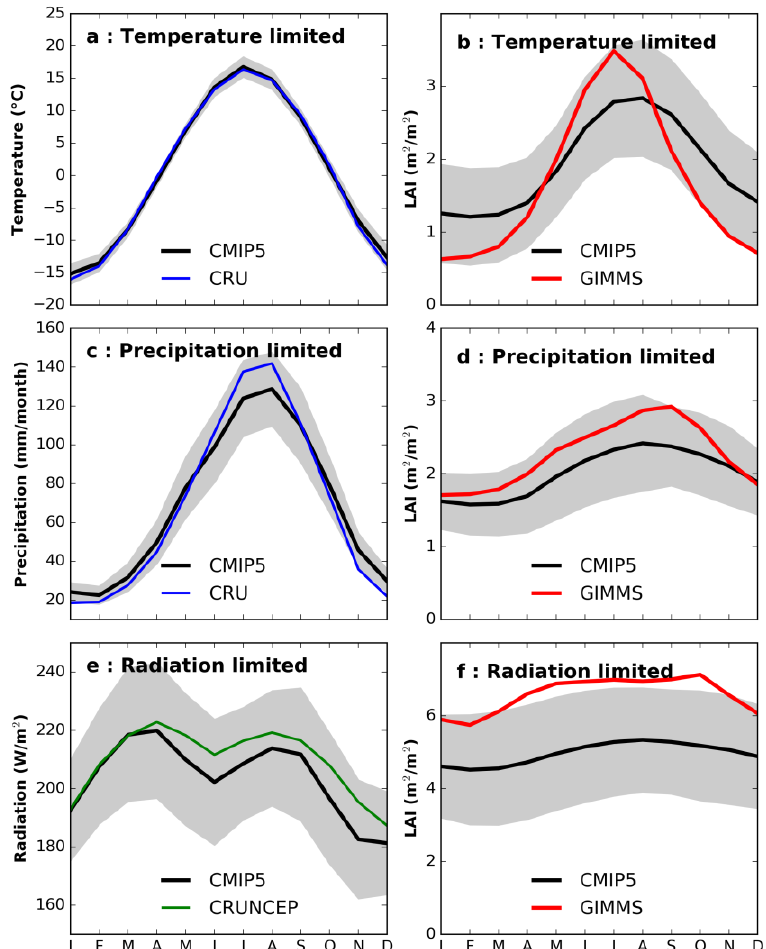
Figure 13. Performance of Earth system models used in CMIP5 against observations (1982–2005) in each of the climate-limiting regions. CMIP5 seasonality for climate and vegetation are ensemble means of each of the parameters. Shading represents standard deviation around the ensemble mean from the CMIP5 models. Observed seasonality in climate and vegetation over the same period is calculated from Climate Research Unit (CRU) (temperature, precipitation), CRU National Centers for Environmental Prediction version (CRUNCEP) (radiation), and Global Inventory Modeling and Mapping Studies Leaf Area Index (GIMMS) LAI.